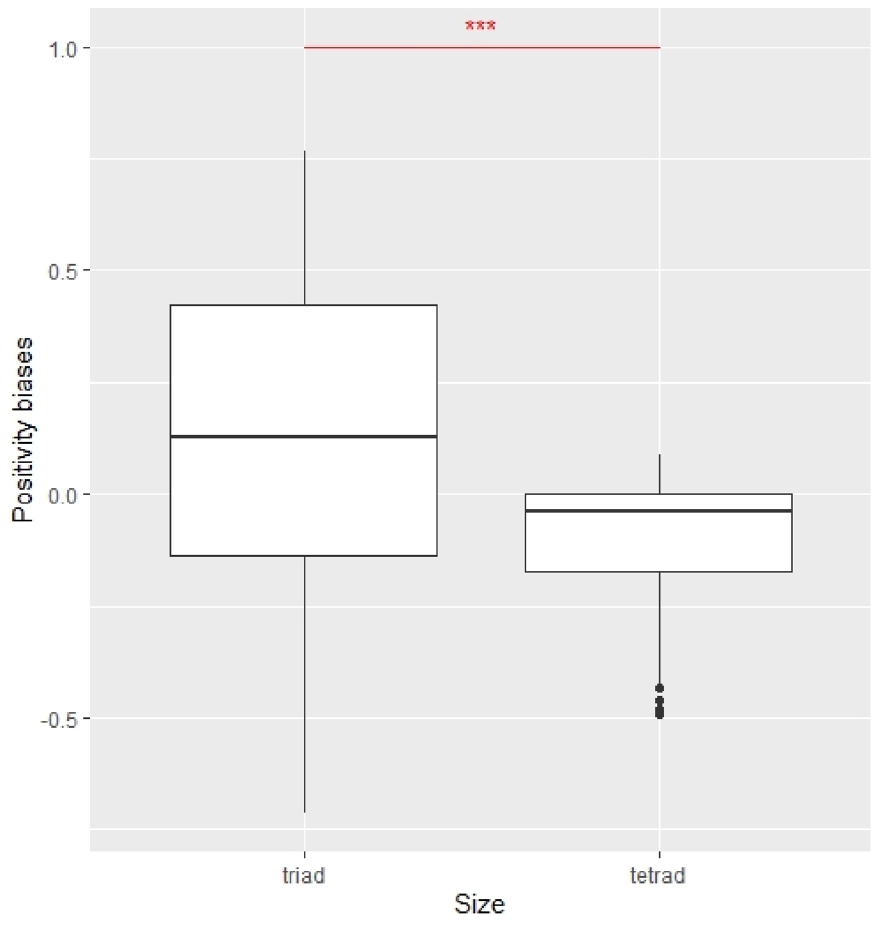
Figure 3. Comparison of average positivity biases ( α + − α − ) of triads and tetrads. The Kruskal–Wallis test was applied. ***p <